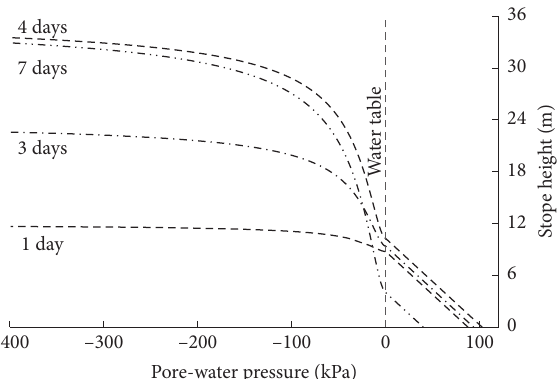
Figure 6: PWP versus stope height for different operation